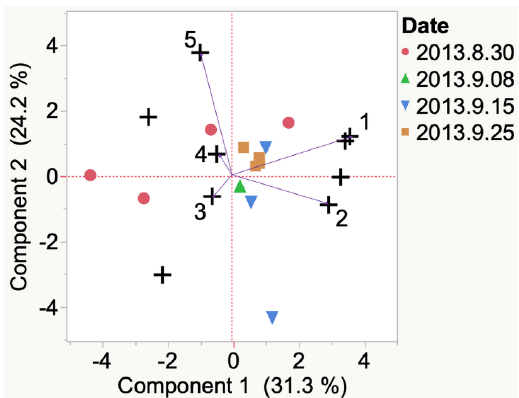
Figure 7. Evolution of VOCs emitted from single berry from veraison to harvest of 2013 St. Croix grapes grown in South Dakota. Key to most representative volatiles from HCA, shown as vectors from the origin and read clockwise: 1 = Nonanal, 2 = Diacetone alcohol, 3 = 1,4-Butanolide, 4 = 5-(Hydroxymethyl)-1-furancarboxaldehyde, 5 = Ethyl acetate.